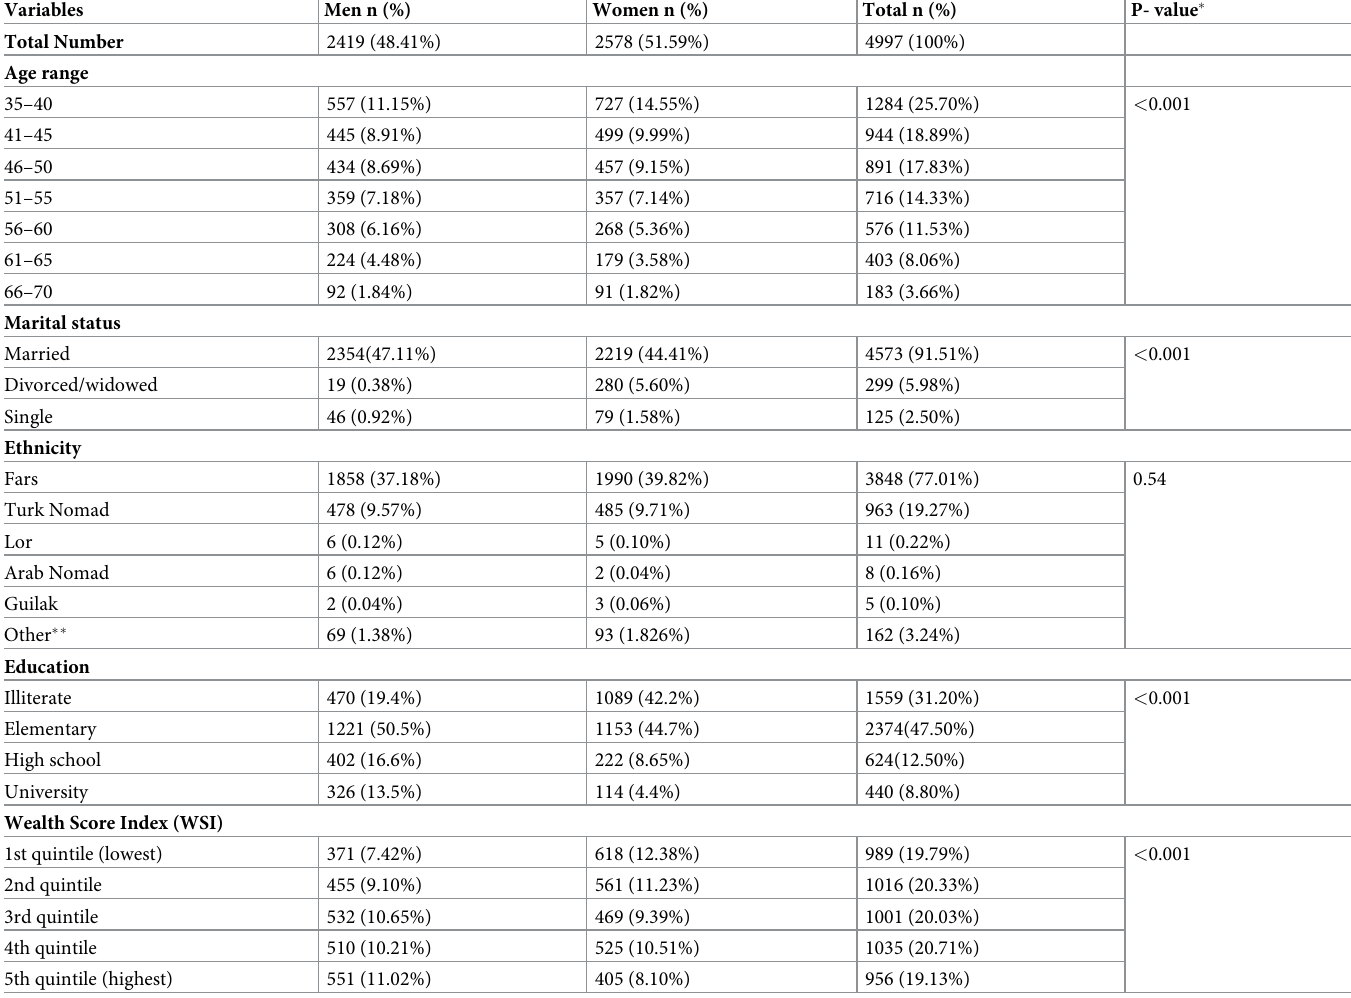
Table 2. Demographic characteristics of participants in